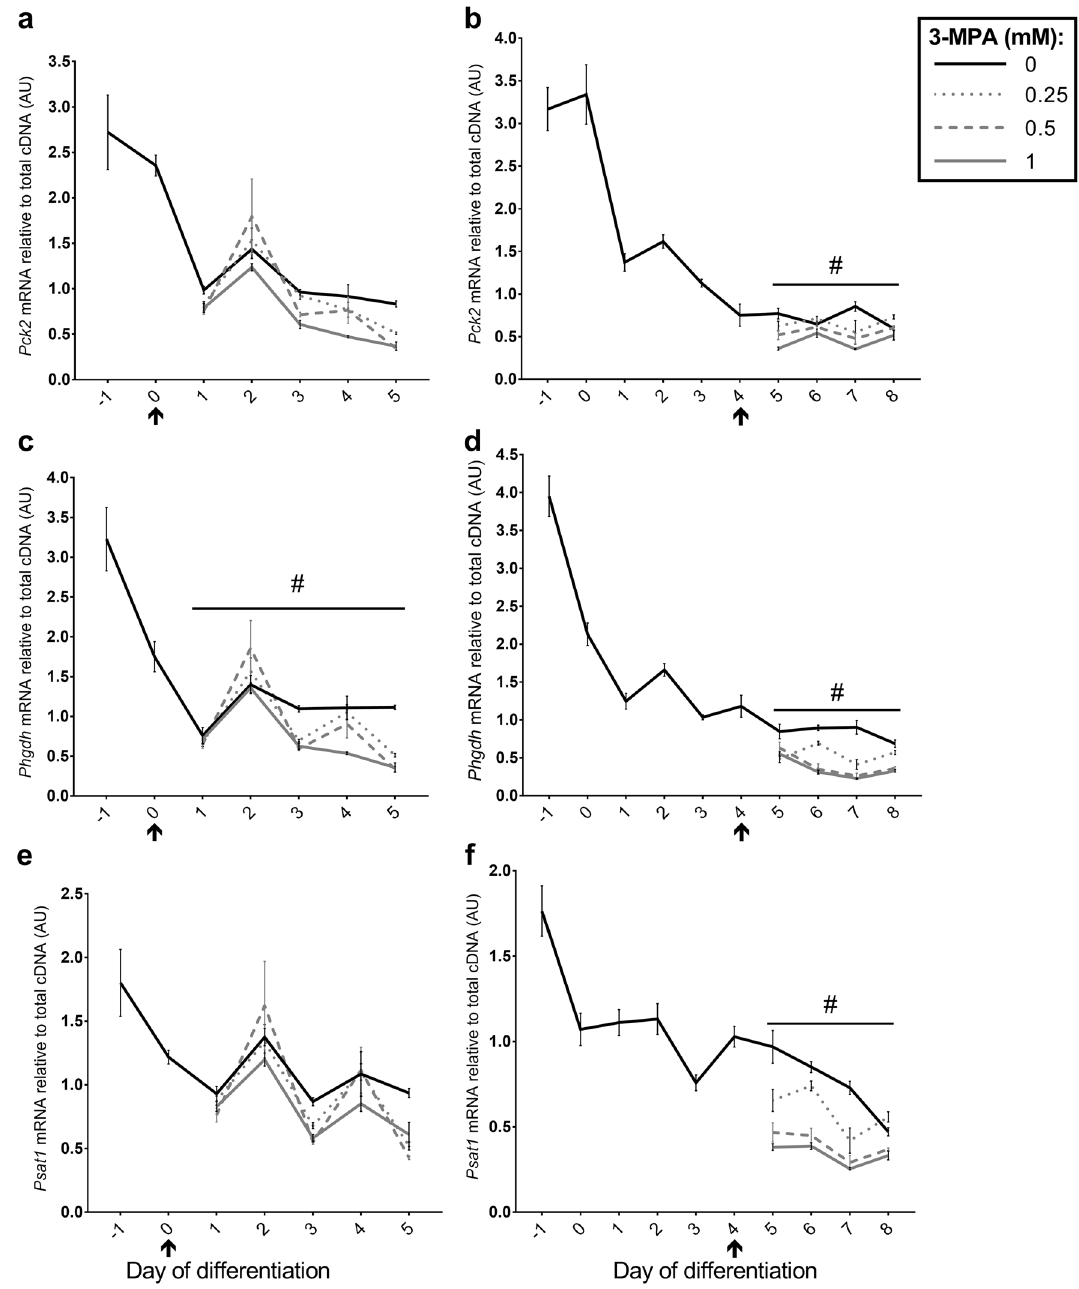
Figure 5. Effect of 3-MPA treatment on genes associated with gluconeogenesis and serine biosynthesis. Relative expression for ( a , b ) Pck2 (encodes mitochondrial PEPCK isoform), ( c , d ) phosphoglycerate dehydrogenase ( Phgdh) and ( e , f ) phosphoserine aminotransferase-1 ( Psat1) mRNA following treatment of C2C12 cells with 0, 0.25, 0.5 or 1 mM 3-MPA from day 0 ( a , c , e ) or day 4 ( b , d , f ) of differentiation. Data presented as Means (n = 4–6) ± SEM. # P < 0.05 (time × treatment interaction). Start of treatment indicated by ↑ . See Supplementary Tables 1 and 2 for Dunnett’s Multiple Comparison